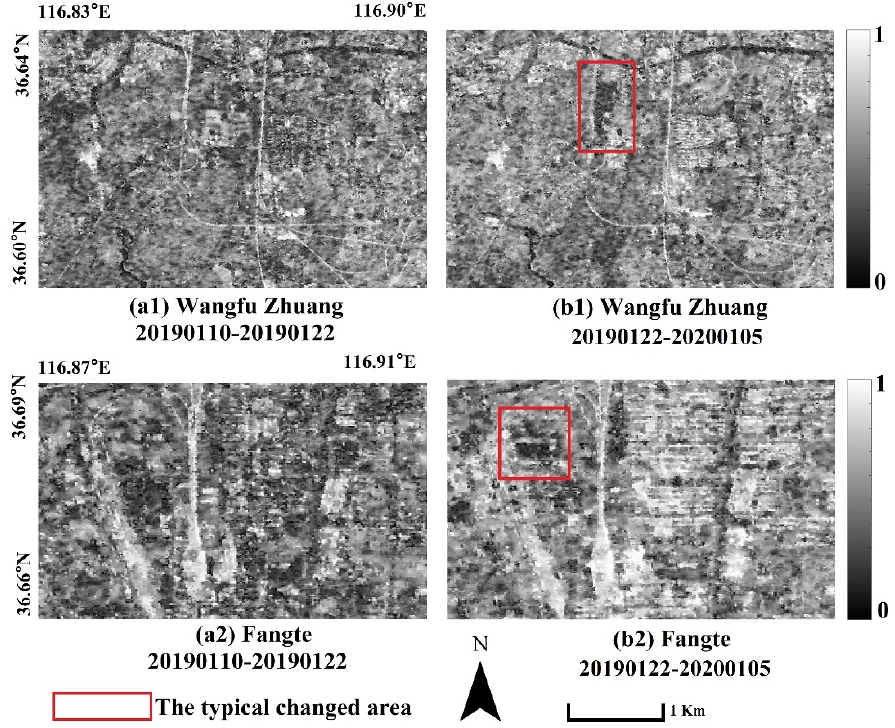
Figure 4. Coherent difference images around ( a ) Wangfu Zhuang Station and ( b ) Fangte Station. Note: ( a1 , b1 ) indicate the coherence coefficients between SAR images obtained on 10 January 2019 and 22 January 2019; ( a2 , b2 ) indicate the coherence coefficients between SAR images obtained on 10 January 2019 and 5 January 2020. Regions within the red rectangles underwent apparent surface changes during the monitoring phase.